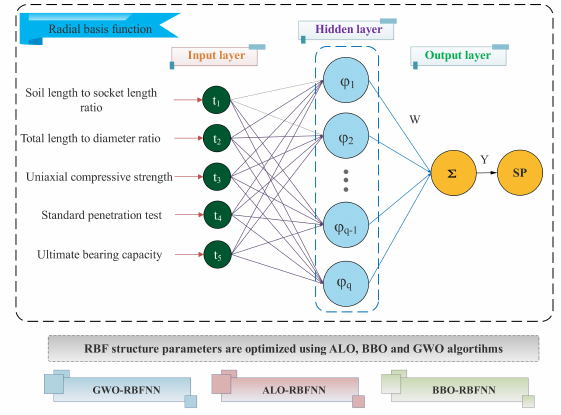
Fig. 7. Radial basis function